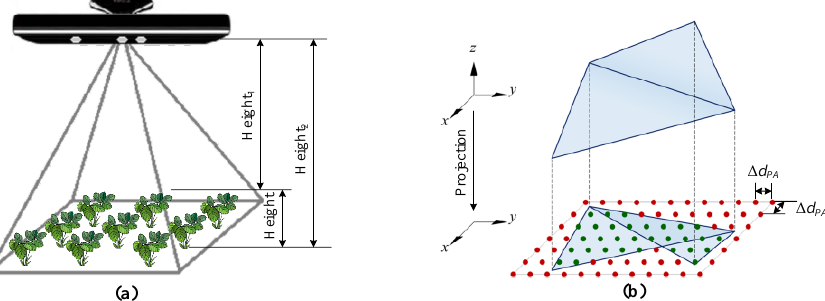
Figure 11. The definition and principle of system measurement method. ( a ) shows the definition of seedling height measurement, where Height1 and Height2 mean the distance between the Kinect sensor, seedling leaf and soil, respectively. Height is the seedling height; ( b ) shows the principle of seedling projected leaf measurement [31].